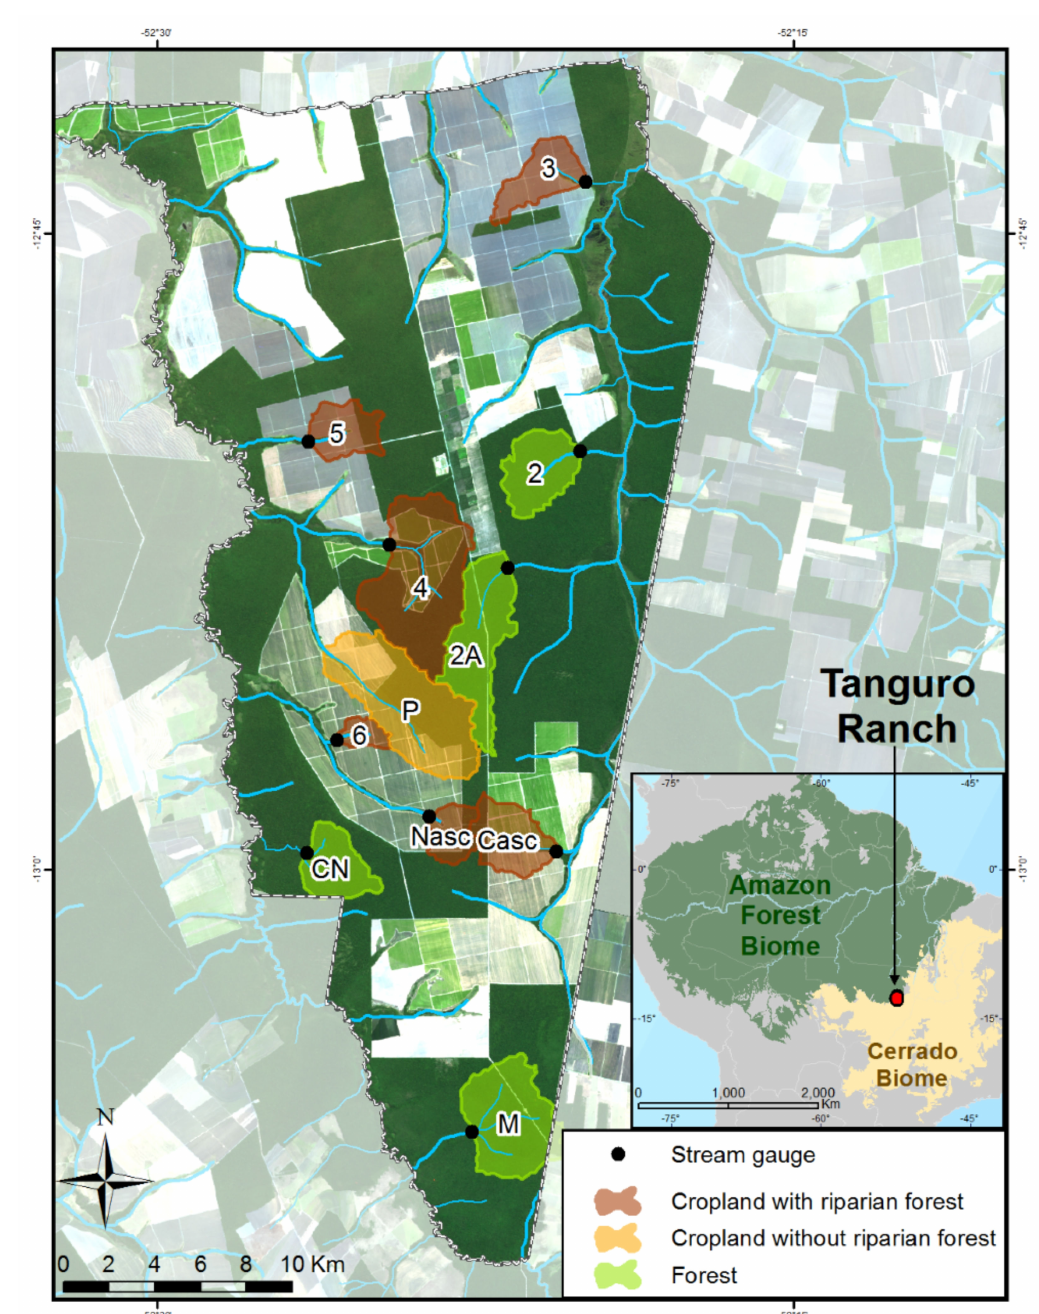
Figure 1. Location of study area and streams. Study watersheds were delineated upstream from the stream gage sampling location (shown in black). Watersheds are shown in colors according to their land use and riparian protection: green (forested), brown (cropland with riparian forest), and orange (cropland without riparian forest; Supplementary Materials, Methods Section). The inset shows the location of Tanguro Ranch (red square) din southeastern Amazonia, with dark green representing closed canopy forests, yellow representing deforested areas, and gray representing areas outside the Brazilian Amazon. Land cover layers are generated from Landsat 8 data